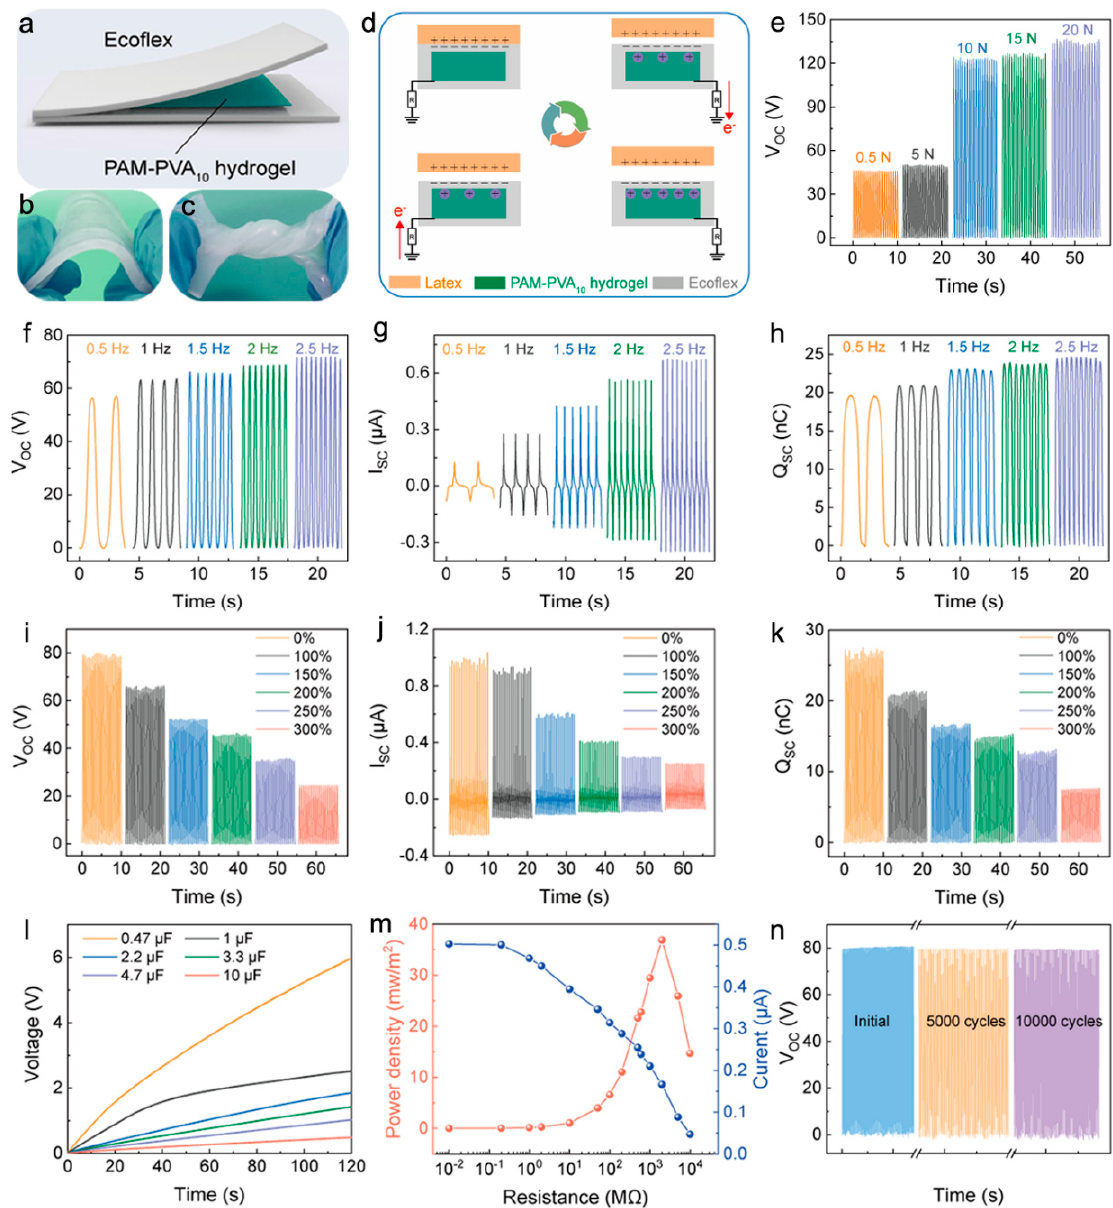
Figure 3. Performance of the SH-TENG based on PAM-PVA 10 hydrogel. ( a ) Schematic diagram of the SH-TENG based on PAM-PVA 10 hydrogel. ( b , c ) Photographs of the SH-TENG in original and twisted states. ( d ) Schematics of the operating principle for the SH-TENG. ( e ) Open-circuit voltages of the SH-TENG at various forces (0.5–20 N). ( f – h ) Open-circuit voltage, short-circuit current, and short-circuit transferred charges under different frequencies of the SH-TENG (0.5–2.5 Hz). ( i – k ) Output performance of the SH-TENG at different stretch rates. ( l ) Charging curves of the SH-TENG for different capacitors. ( m ) Output current and power density of the SH-TENG under various load resistances. ( n ) Output electrical stability test of the SH-TENG for 10,000 contact–separation cycles (at 1 Hz).